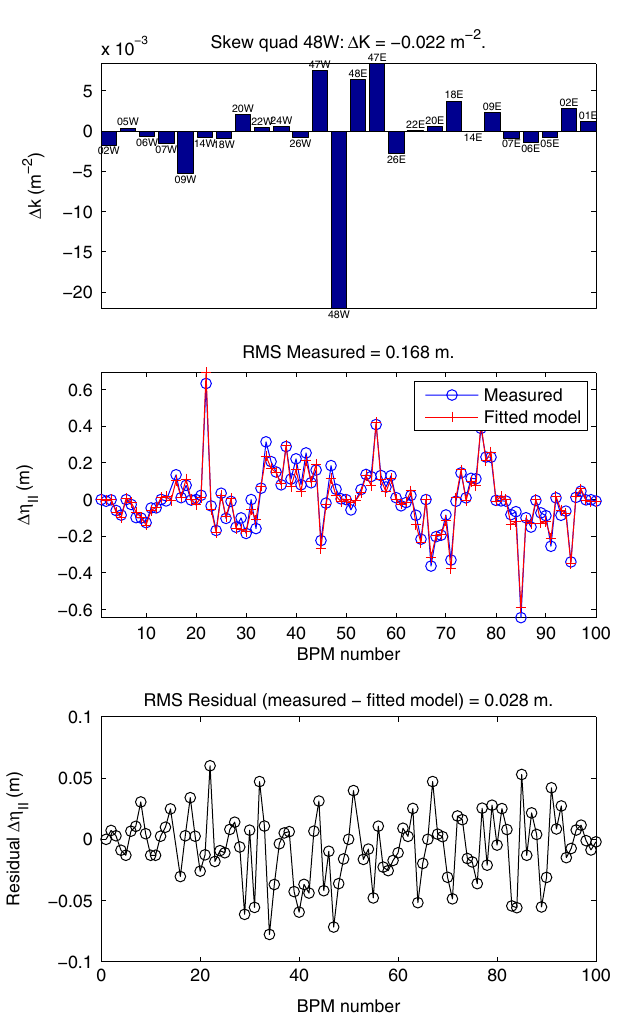
FIG. 11. Effect of change in strength of skew quadrupole 48W on mode II dispersion in CesrTA. Top: skew quadrupole strengths in a model fitted to the measured mode II dispersion. Center: comparison between measured mode II dispersion and the mode II dispersion in the fitted model. Bottom: residual between measured and fitted mode II dispersion. The rms is the root mean square over the measurements at the